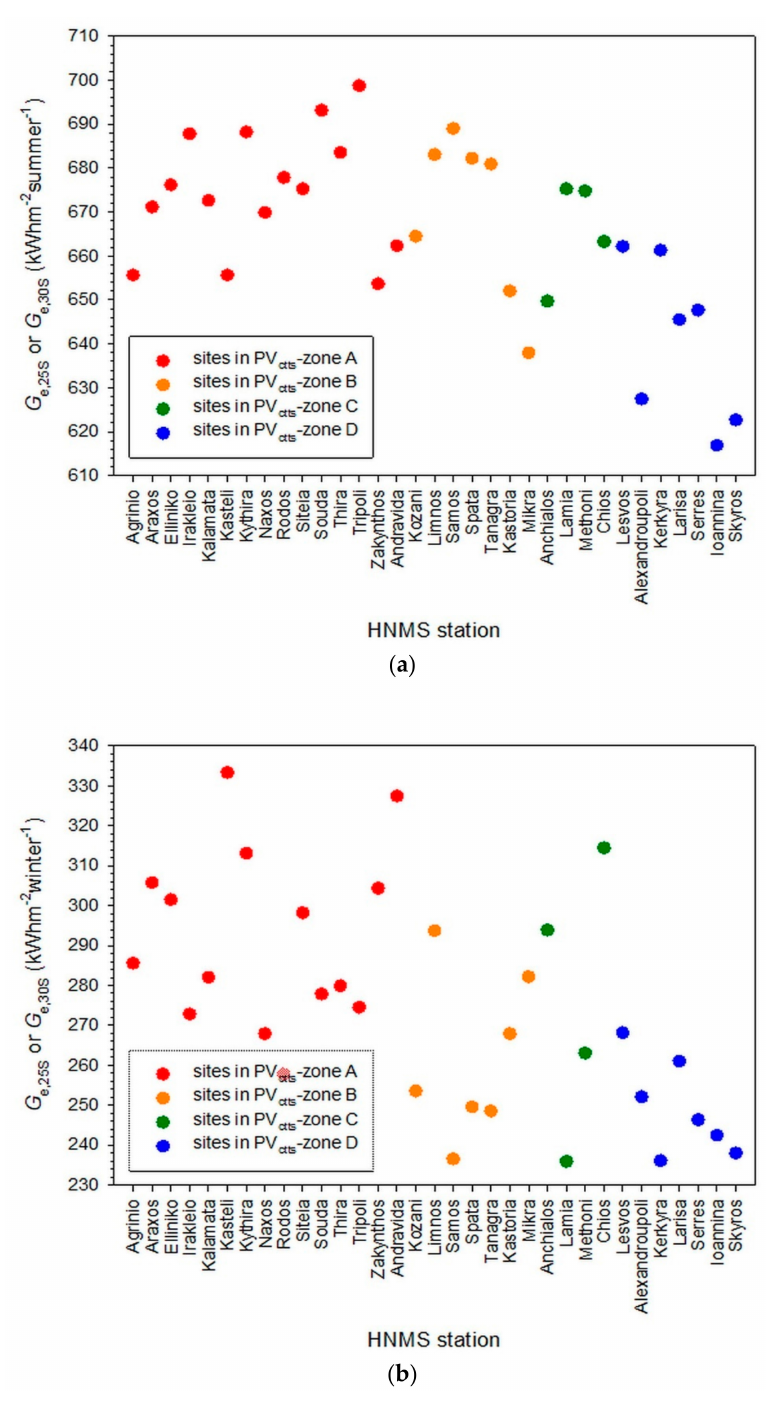
Figure 9. Summer ( a ) and winter ( b ) G e values across all sites on inclined flat plates of 25 ◦ S or 30 ◦ S angles. The sites are cited in alphabetical order within the same PV ctts